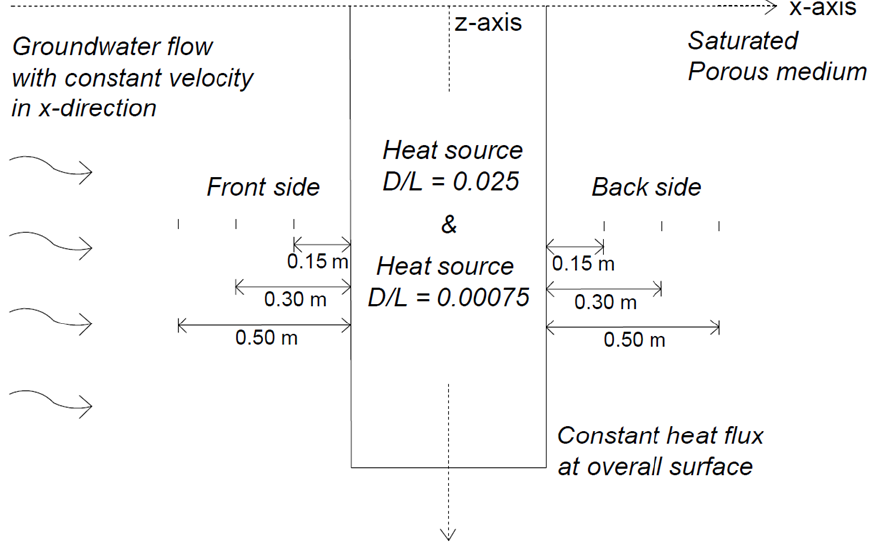
Figure 1. Schematic overview of the numerical model.